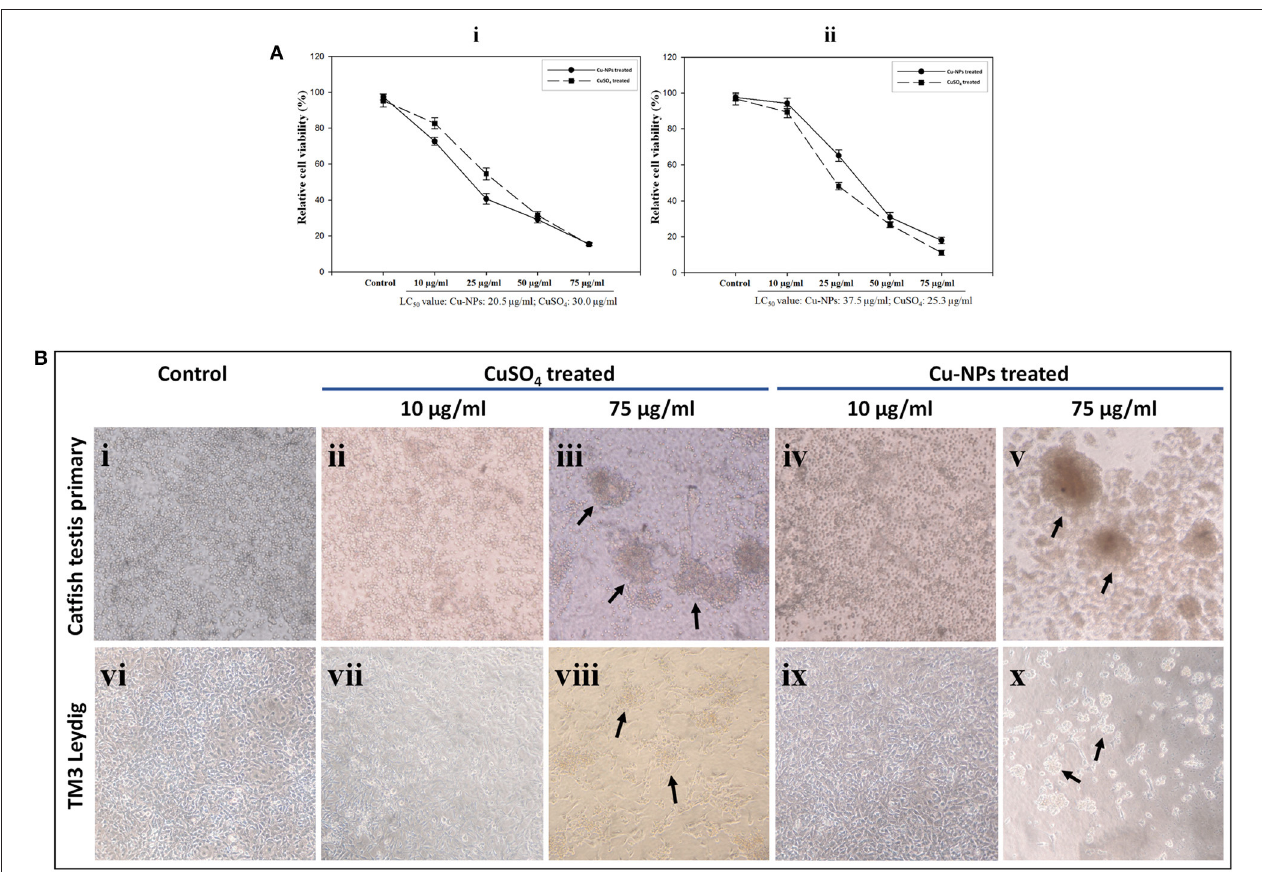
FIGURE 6 | Cytotoxic effect of CuSO 4 and Cu-NPs with different concentrations exposed to catfish testis primary culture (Ai) and TM3 Leydig cell line (Aii) for 48h incubation. Relative cell viability (%) was determined for cells exposed to PBS (control) and CuSO4 and Cu-NPs (treated) by MTT assay as described in Section Mitochondrial function assay (Ai,ii). All results were expressed as total percentage of viable cells with mean ± SEM of three independent determinations with ( n = 5) for each point ( P < 0.05; statistically significant difference compared with control). Microcopy based assessment of catfish testis primary culture and TM3 Leydig cell line of control (Bi,vi) , CuSO4 (Bii,iii,vii,viii) and Cu-NPs (Biv,v,ix,x) , respectively. Indicated doses of CuSO4 (equivalent amount of copper load) and Cu-NPs were exposed to the cells for 48 h in serum free DMEM. Arrows highlight loss of adhesion and cell clumping as signs for toxicity. Cells exposed to other indicated concentrations showed the same morphology and hence, we provided the low and high doses studied in the